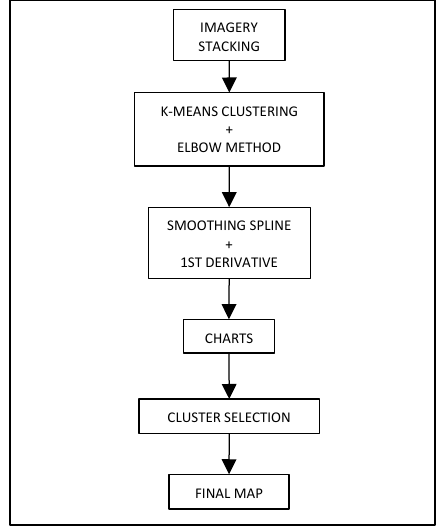
Figure 6. Workflow for mapping agricultural